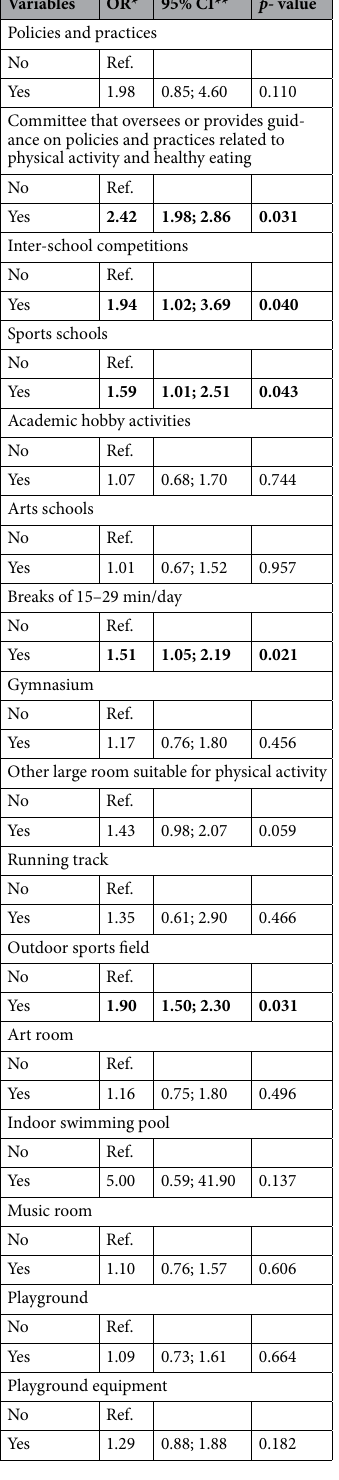
Table 5. Multilevel logistic regression (OR [95%CI]) of school environment on achievement of physical activity recommendation of children. Values in bold indicate significant associations. Multilevel logistic regression, including school as a random effect, adjusted for sex, ethnicity, school type, number of siblings, total annual household income and school. * OR odds ratio. **95% CI confidence